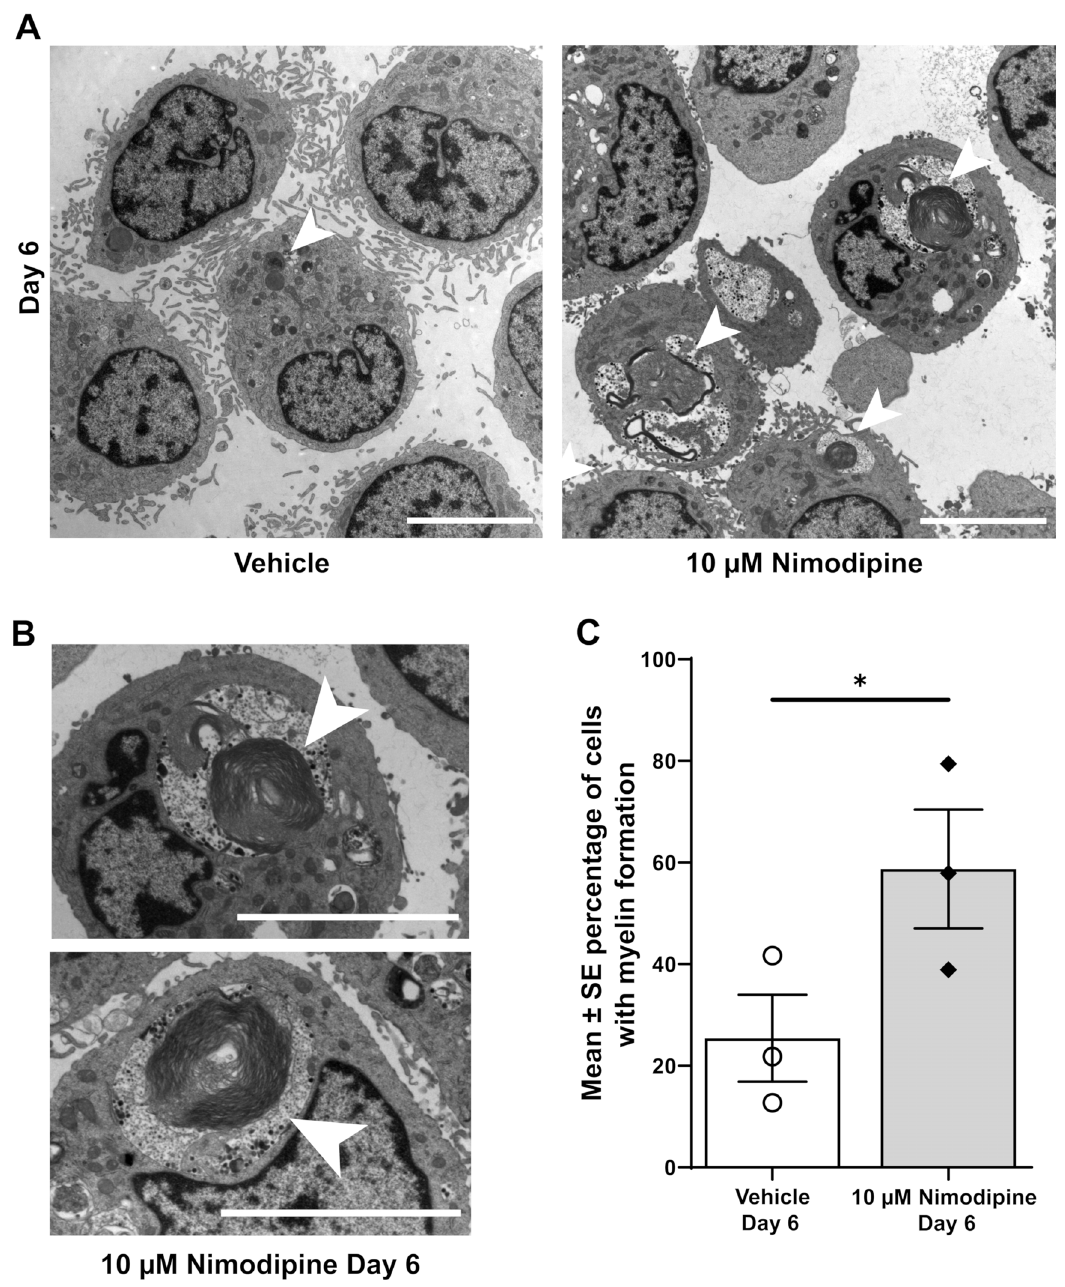
were incubated with nimodipine compared with the vehicle solution ( p < 0.01; Figure 3B).